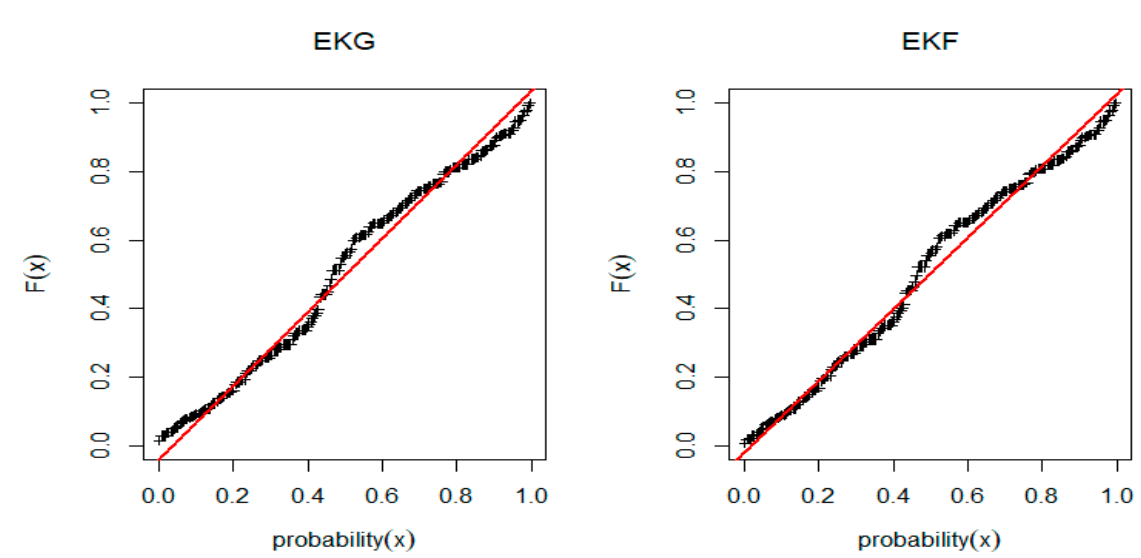
Figure 9. PP-plot for EKG and EGF distribution for Australian Athletes data. Table 13. MLE and the Bayesian estimates for the fitted MEKGEF model for the Australian athletes data.